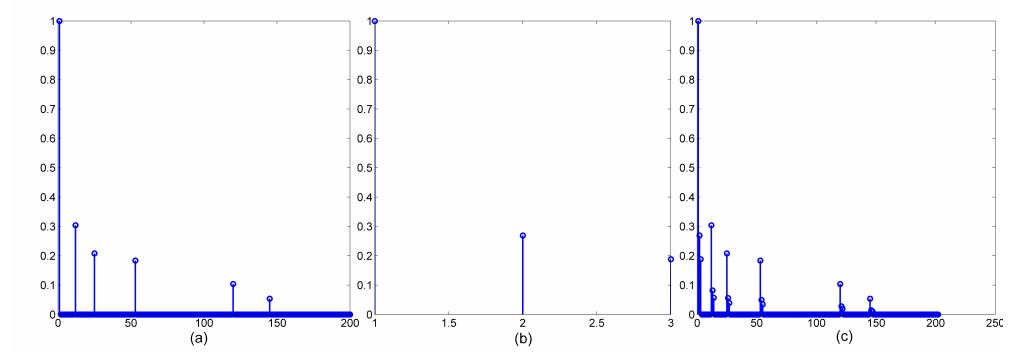
Figure 4. ( a ) UWA channel response h SI _ ch ; ( b ) PA memory response h PA ; ( c ) nonlinear channel response h SI